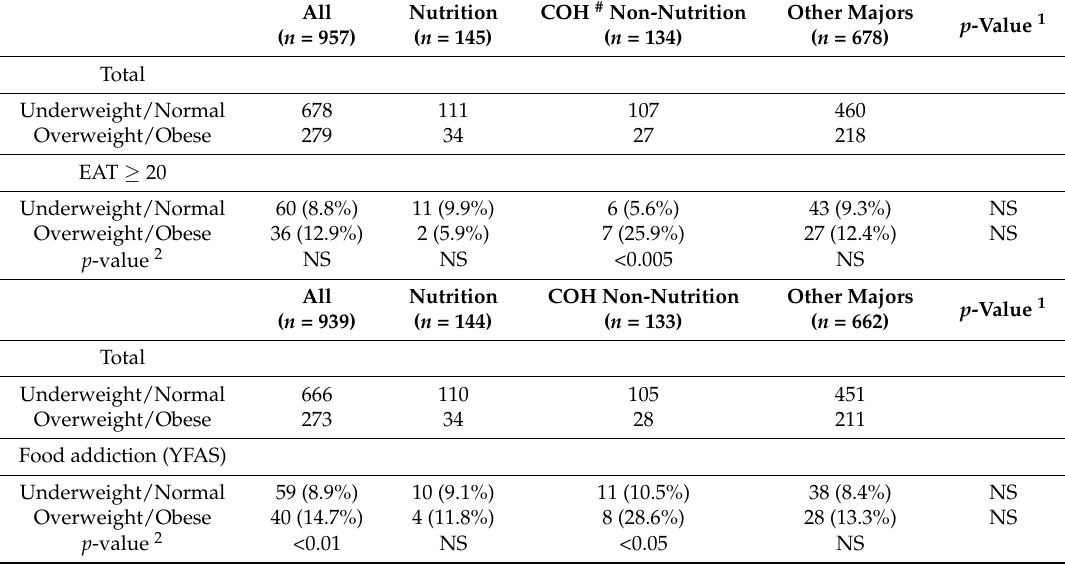
Table 3. EAT Score ≥ 20 and food addiction diagnosis by weight status